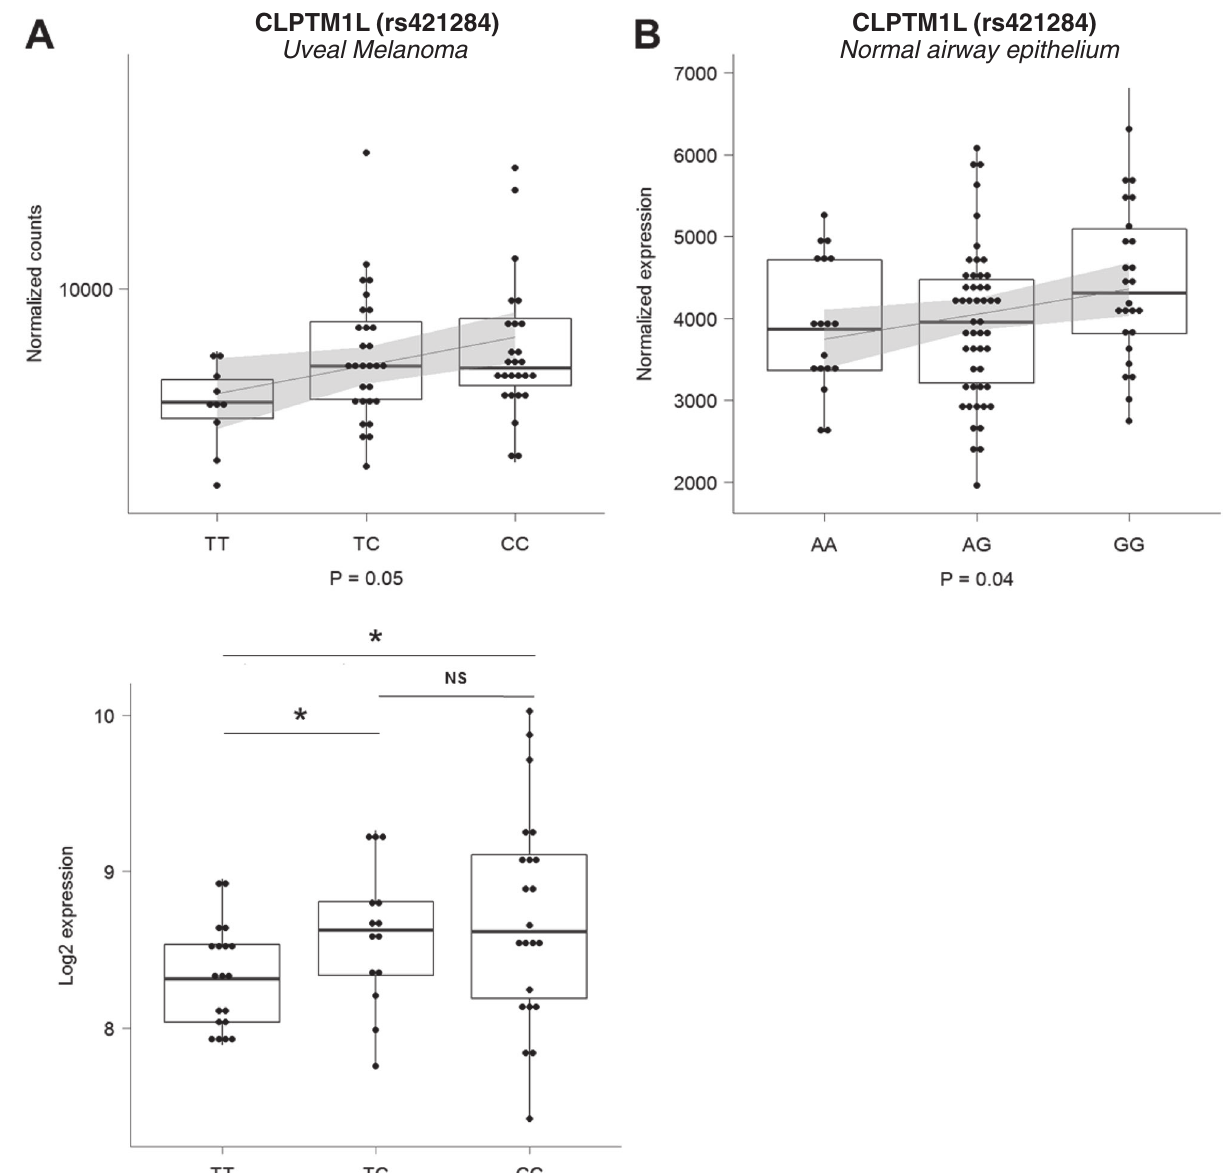
Fig. 3 Expression of CLPTM1L according to SNP genotype at 5p15.33. a Expression QTL (eQTL) was performed for rs421284 on uveal melanoma (UM) from two series of UM patients. Upper panel : series described in ref. 13 Lower panel : series described in ref. 14 b Expression QTL (eQTL) was performed for rs465498 on normal airway epithelium from public dataset GSE40364. Linear regression was applied for series described in ref. 13 and GSE40364 (validated homoscedasticity), and the nonparametric Behrens – Fisher problem was applied for the series described in ref. 14 NS Non Signi fi cant, * P <